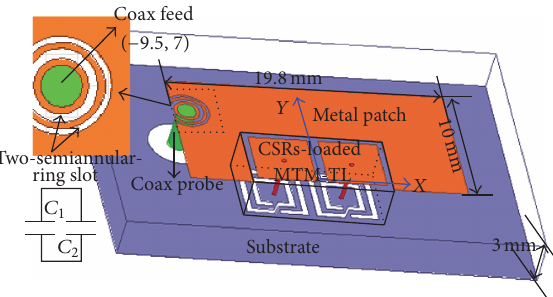
Figure 9: Schematics of the proposed antenna with geometrical parameters (in mm).